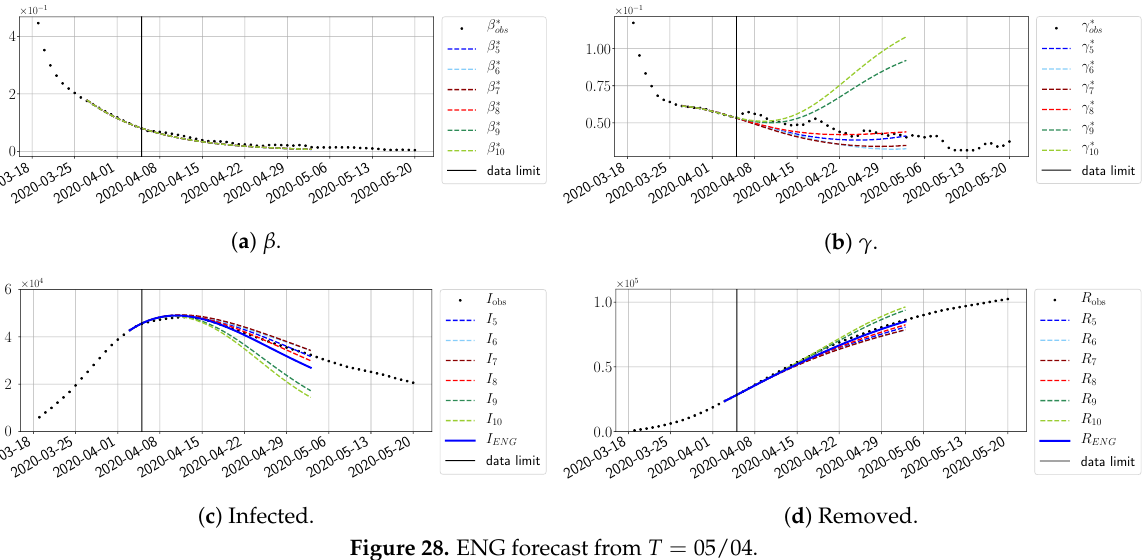
Figure 28. ENG forecast from T = 05/04.